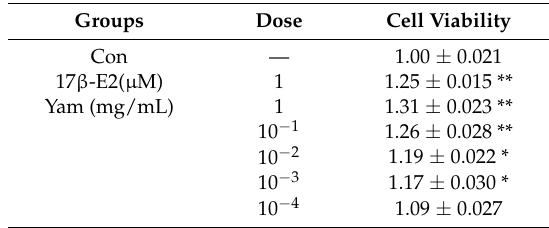
Table 1. Effect of yam extract on MCF-7 cell proliferation (x ± SD, n = 4).